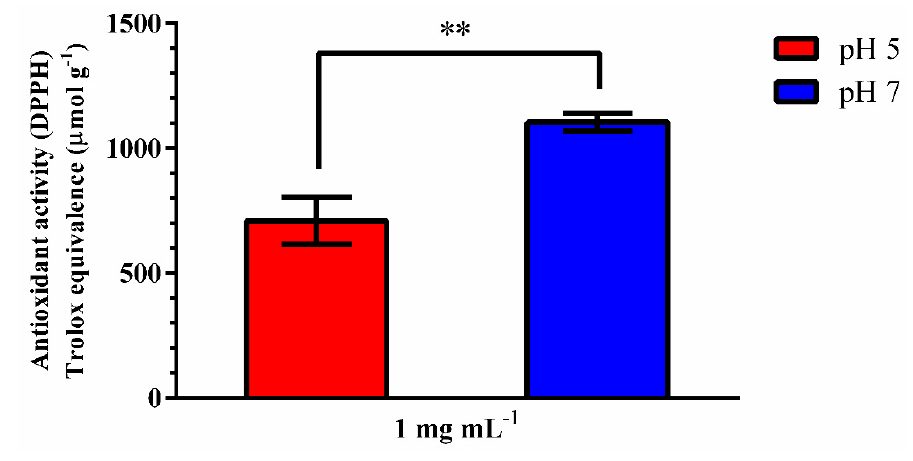
Figure 1. Antioxidant activity of 1.0 mg mL − 1 grape pomace extract ( Vitis vinifera ) at pH values 5 and 7 ( n = 3). ** = p < 0.001.